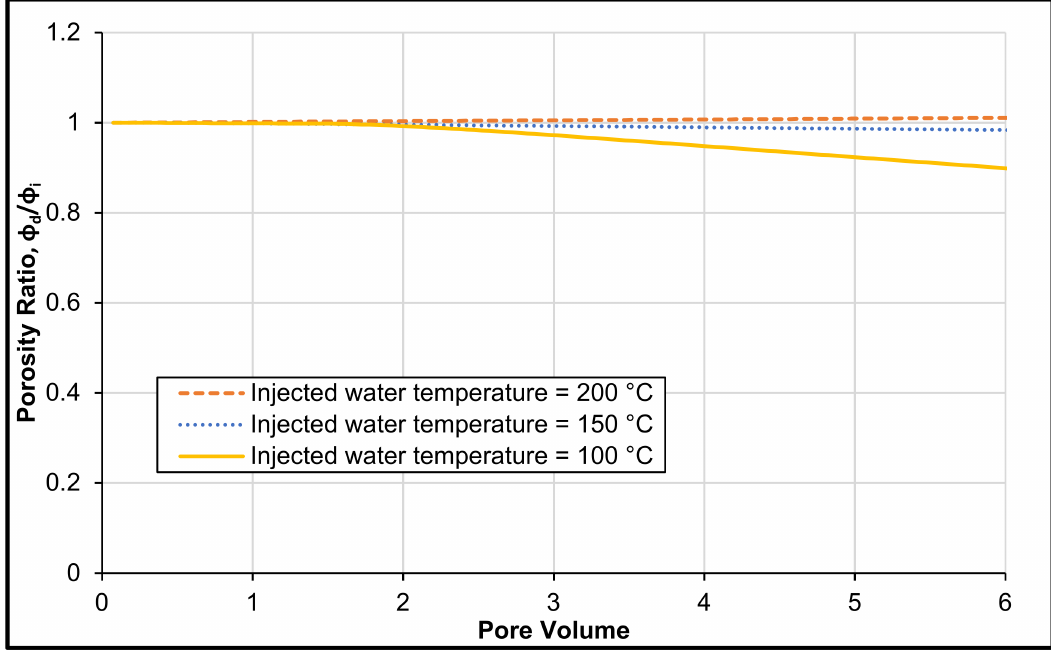
Figure 6. Injected water temperature effect on formation porosity ratio for the first gridblock at 6 PVs with fixed reservoir temperature of 200 ◦